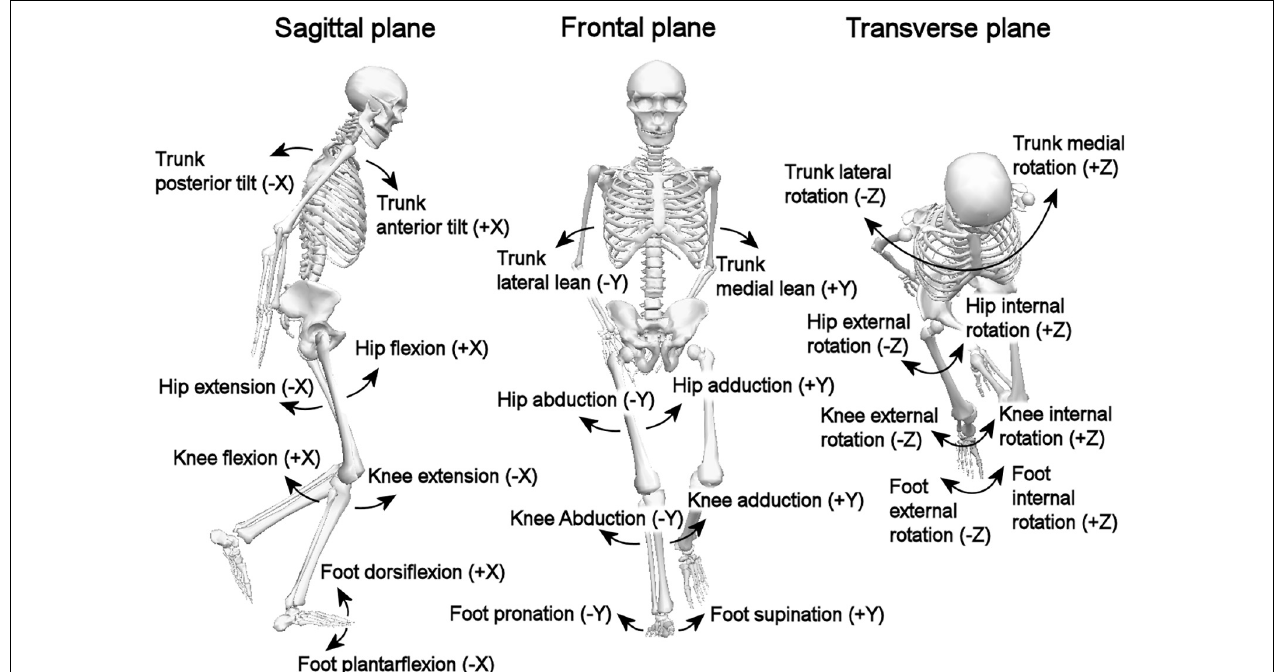
FIGURE 1 | The segments/joints and